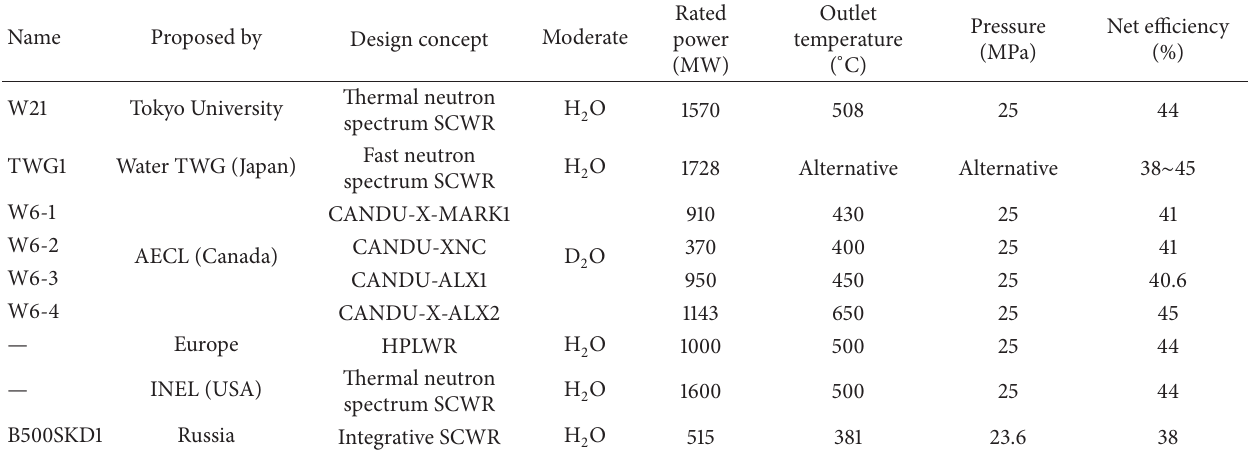
Table 1: Some typical SCWR concepts around the